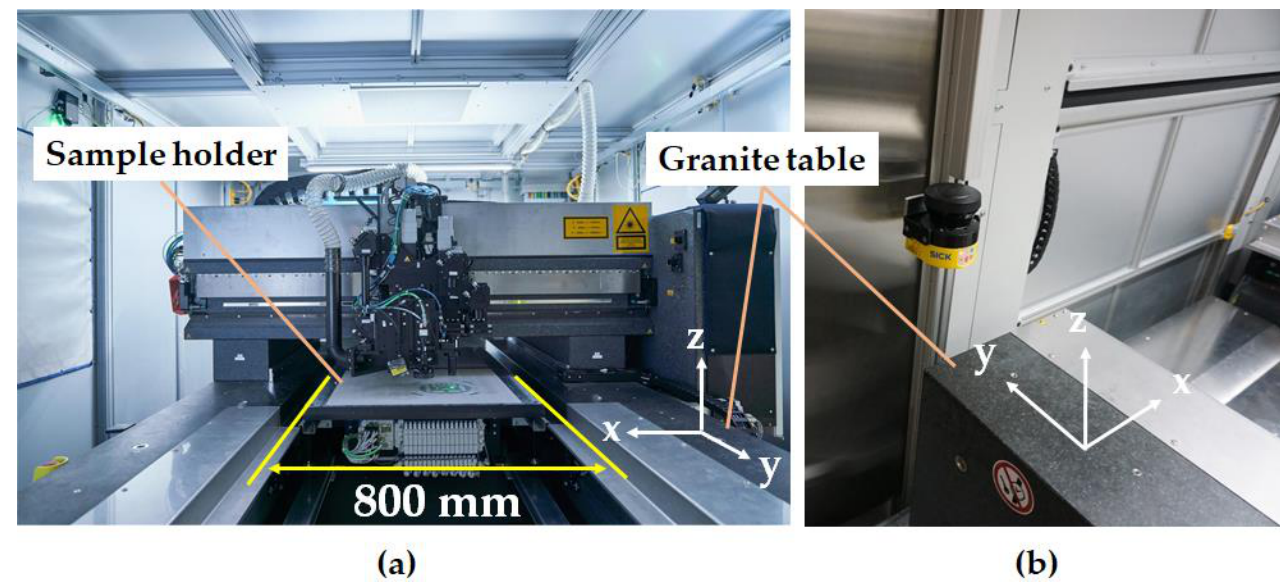
Figure 1. ( a ) Interior of the microSHAPE TM USP laser system at SCHOTT AG. The system is accessible and equipped with several safety systems that are intended to prevent staff from entering the machine during laser operation. One of these safety systems is the Sick laser scanner device ( b ) installed in the wall in front of the operating machine system. The monitored area covers the region between 10 cm and 30 cm above the granite table.